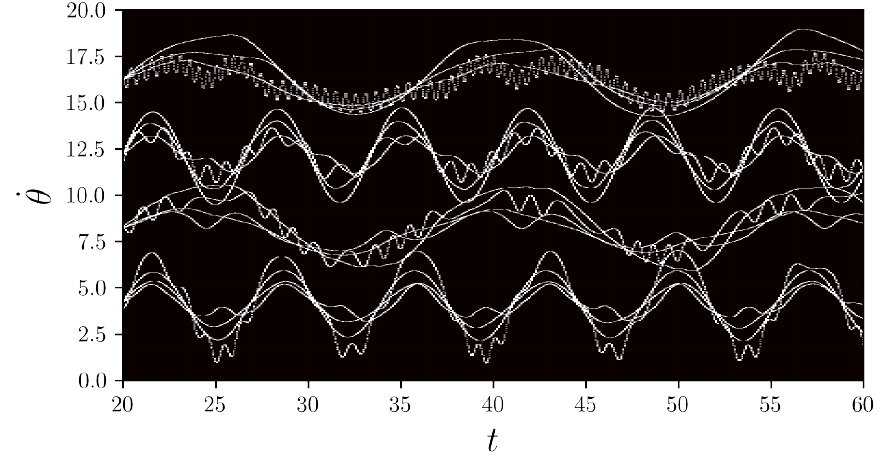
Figure 3. Matrix B represented as a binary histogram (white bins does have trajectories, while black ones does not).